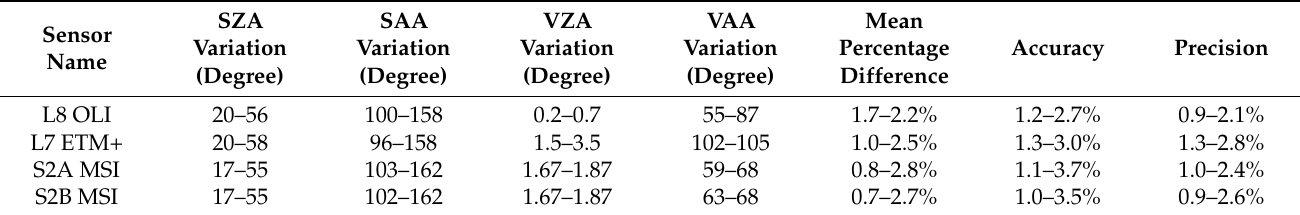
Table 11. Model specifications by analyzing different nadir viewing sensors using scene center ROI.